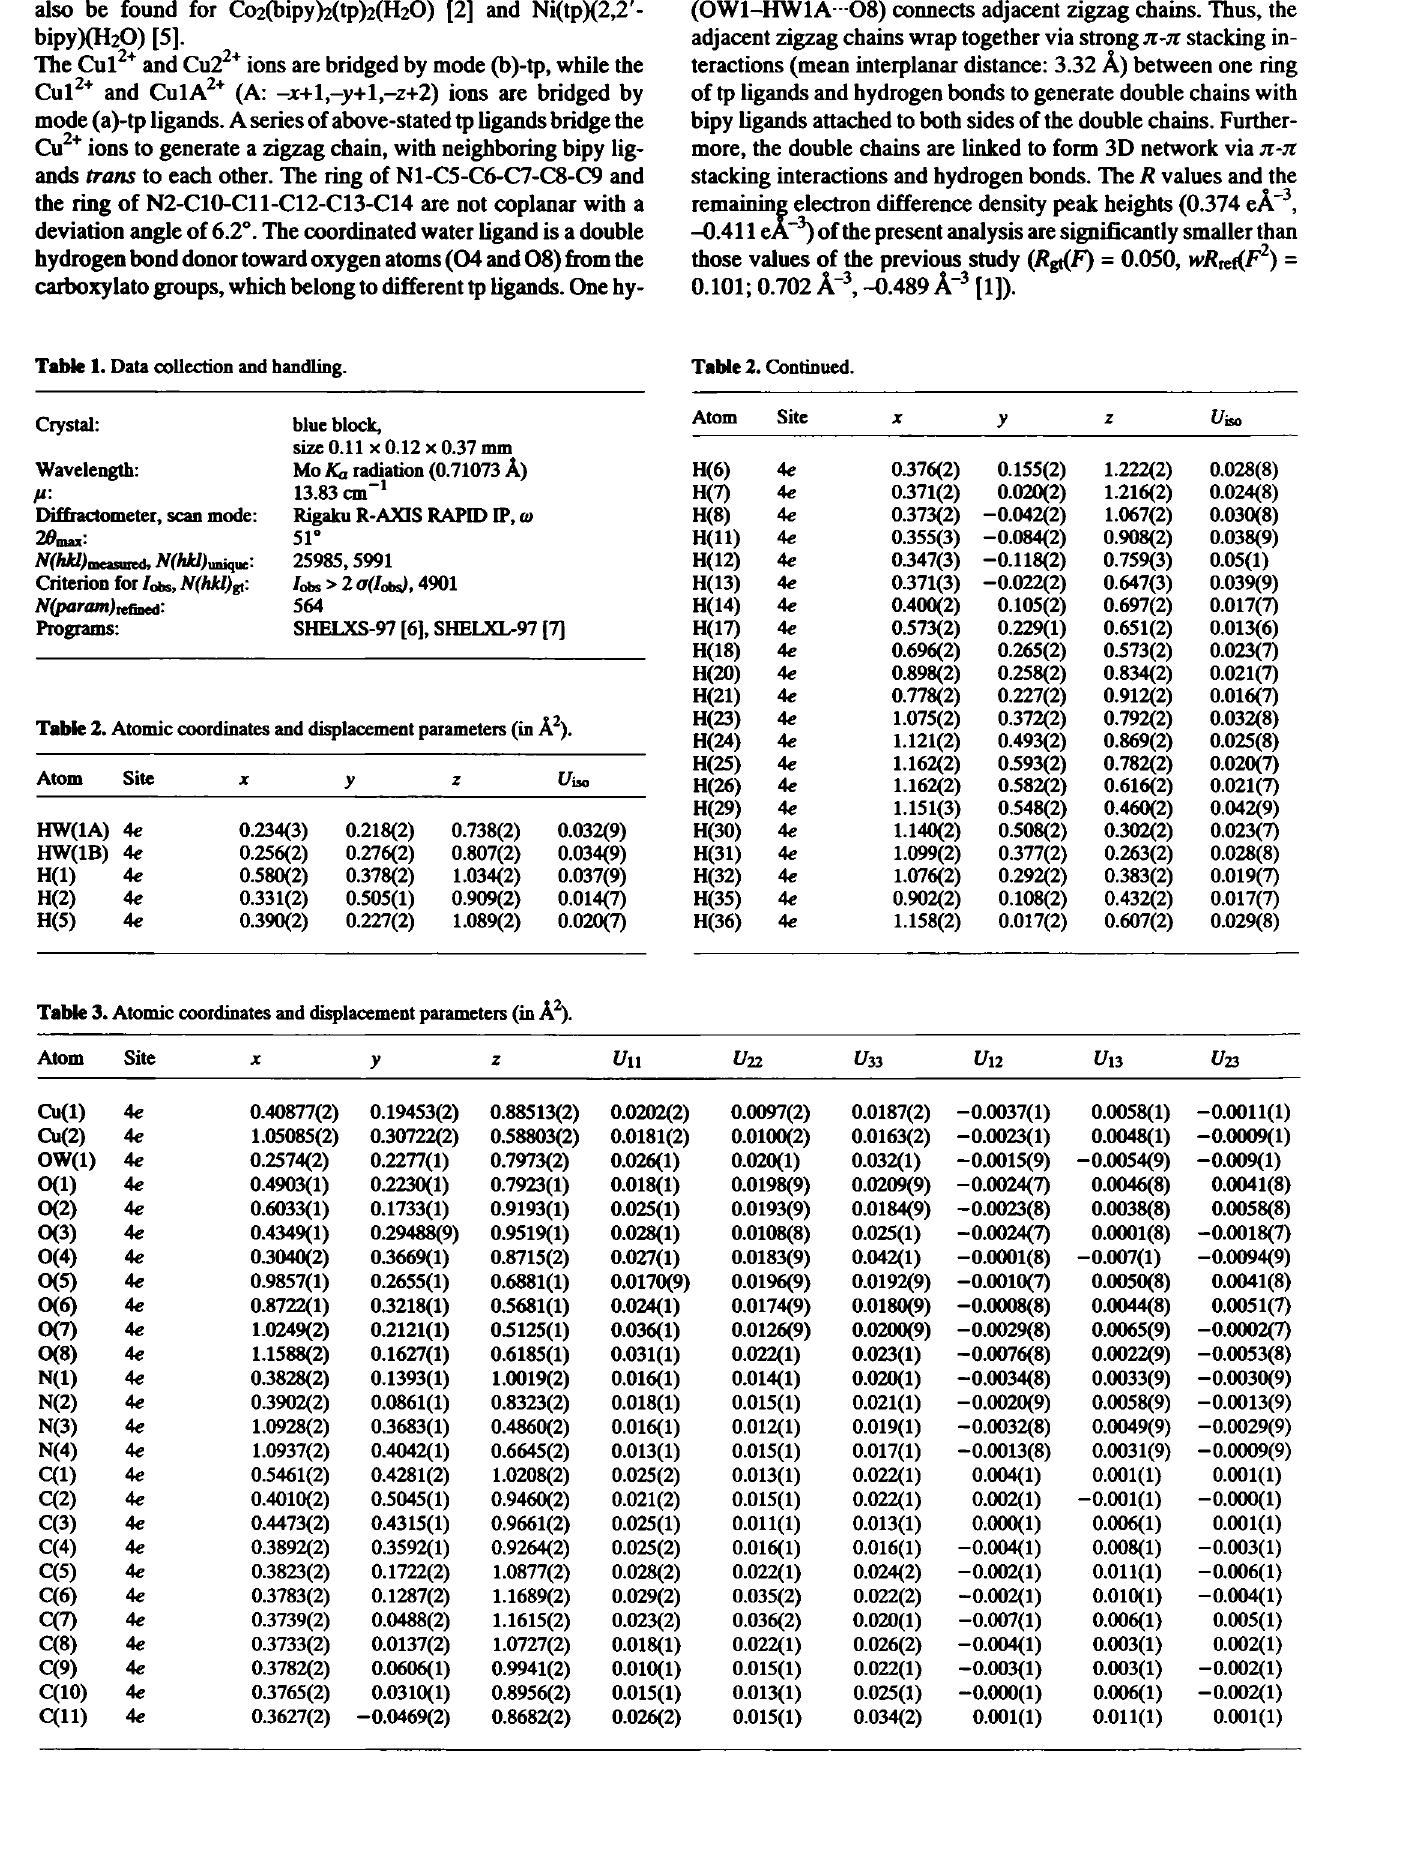
Table 1. Data collection and handling. Table 2. Continued.